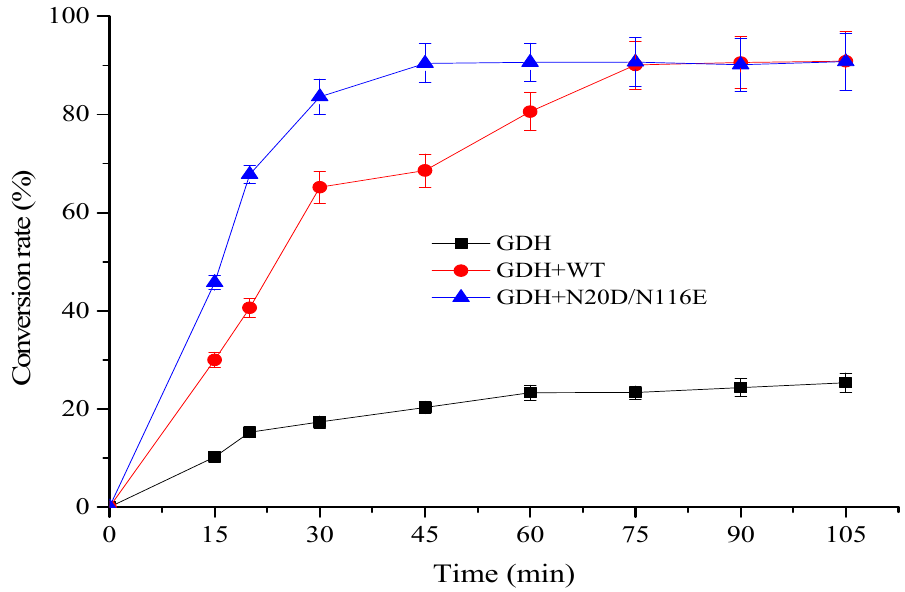
Figure 9. Time profile of conversion of L-Glu into α -KG by coupling GDH with NOXs.